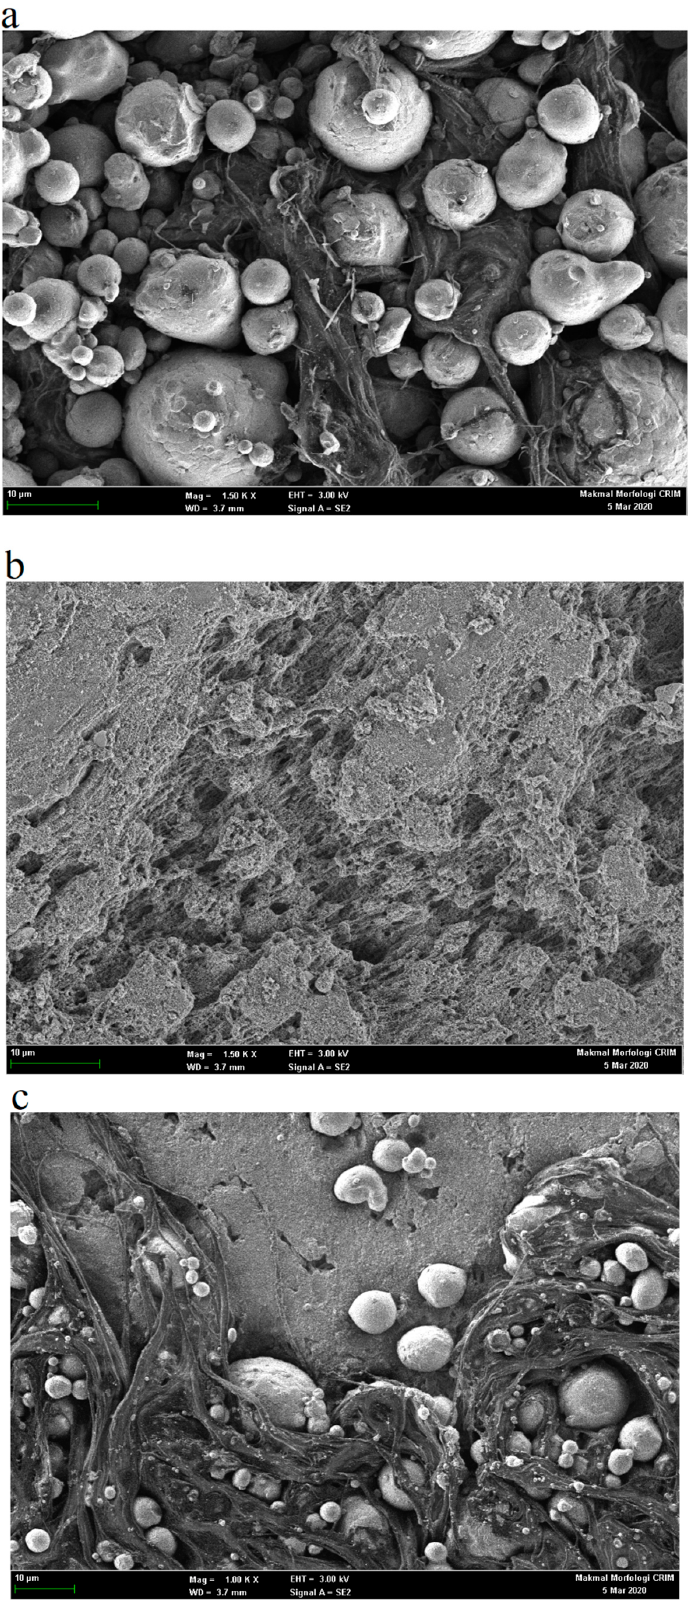
Figure 15. FESEM images of the samples solvent debound at 70 °C after 40 min of immersion: ( a ) SS 17-4PH micro-part; ( b ) 3YSZ micro-part; and ( c ) SS 17-4PH/3YSZ bi-material micro-part.